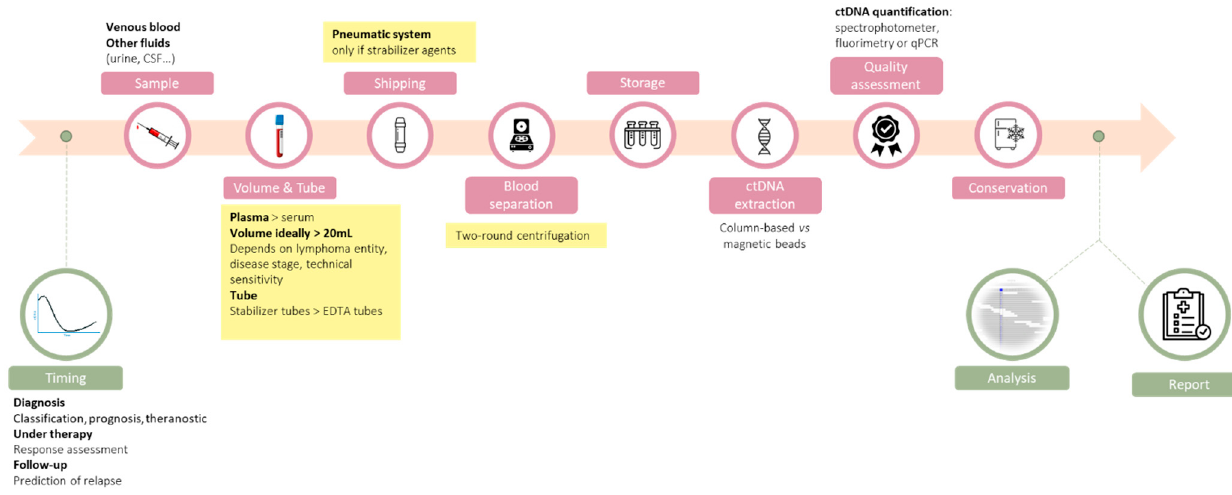
Figure 1. Overview of the ctDNA analysis workflow, with an emphasis on the preanalytical steps that are detailed in this review. When sufficient levels of evidence exist, our recommendations are highlighted in yellow.